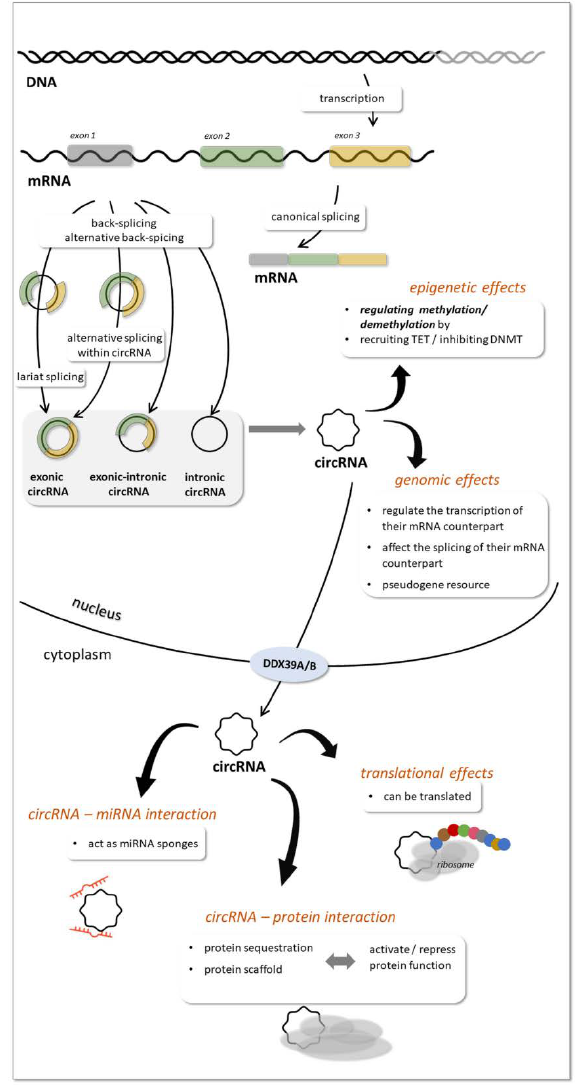
Figure 4. circRNAs biogenesis and function (see details in the text) .